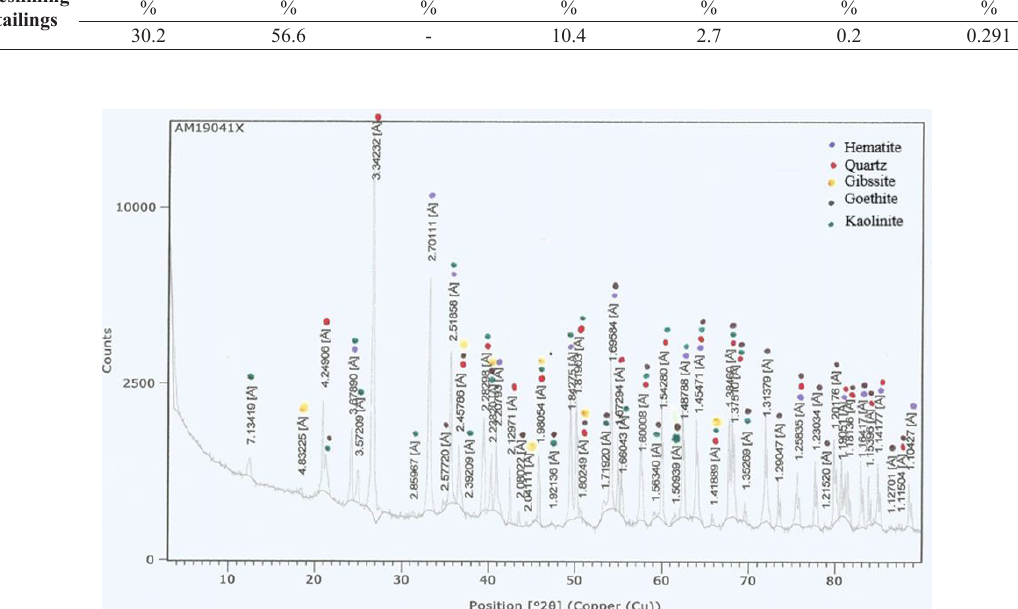
Table 2. Percentage by mass of crystalline phases present in the sample Desliming tailings